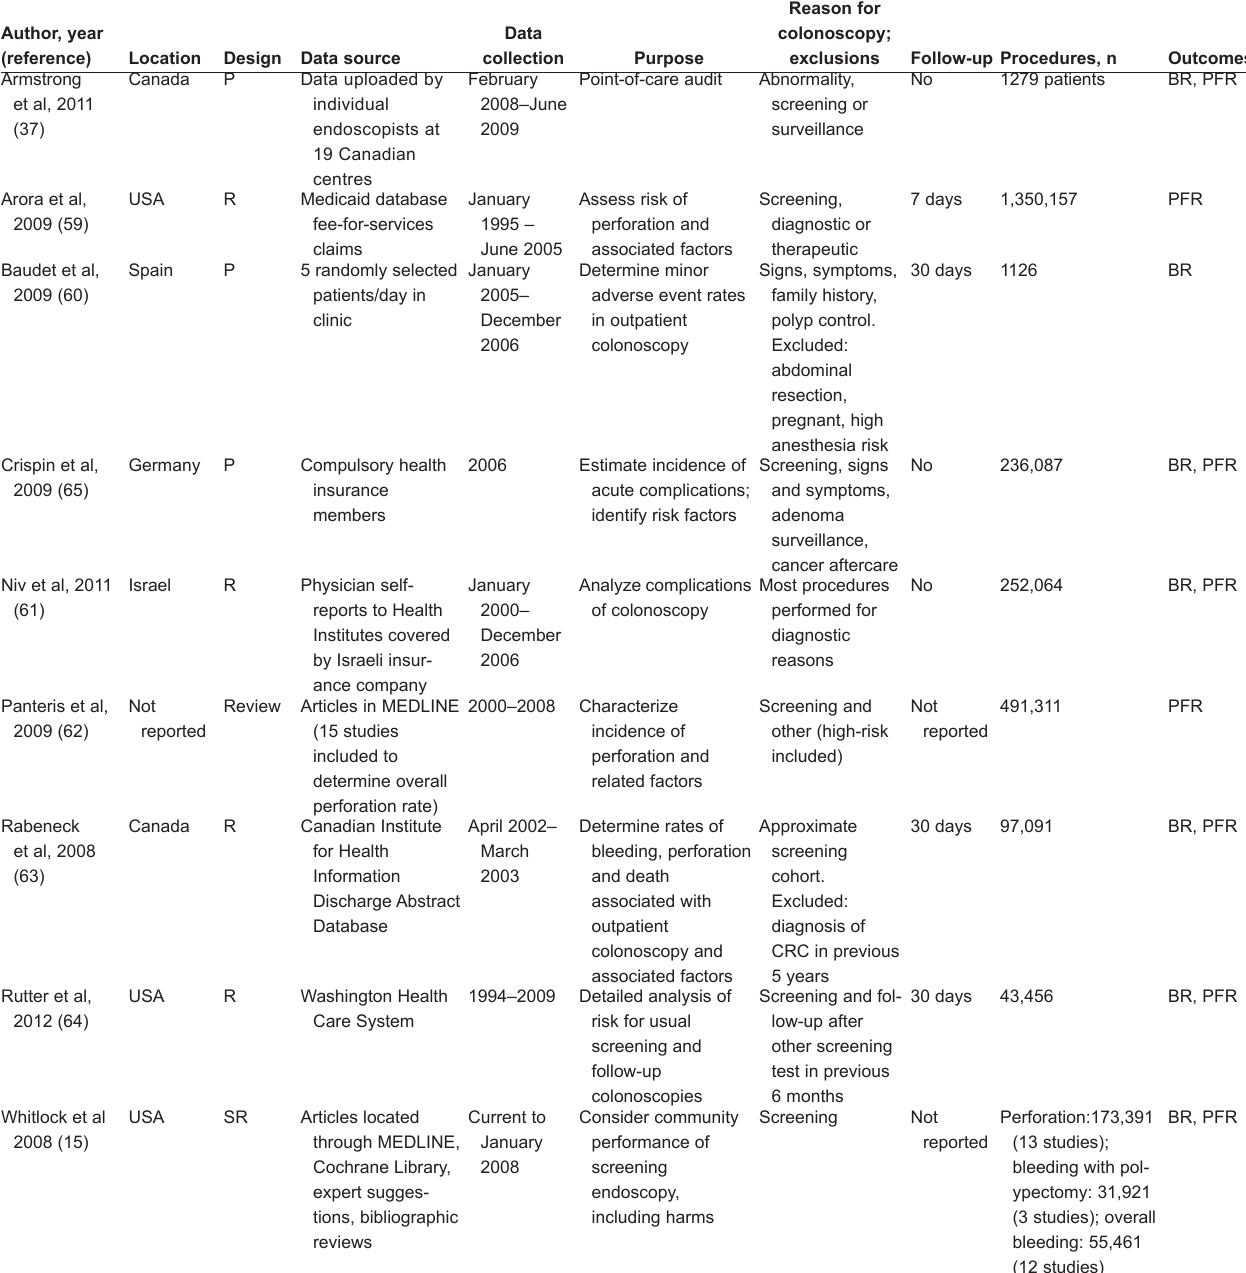
TAble 10 Study characteristics, indicators of colonoscopy